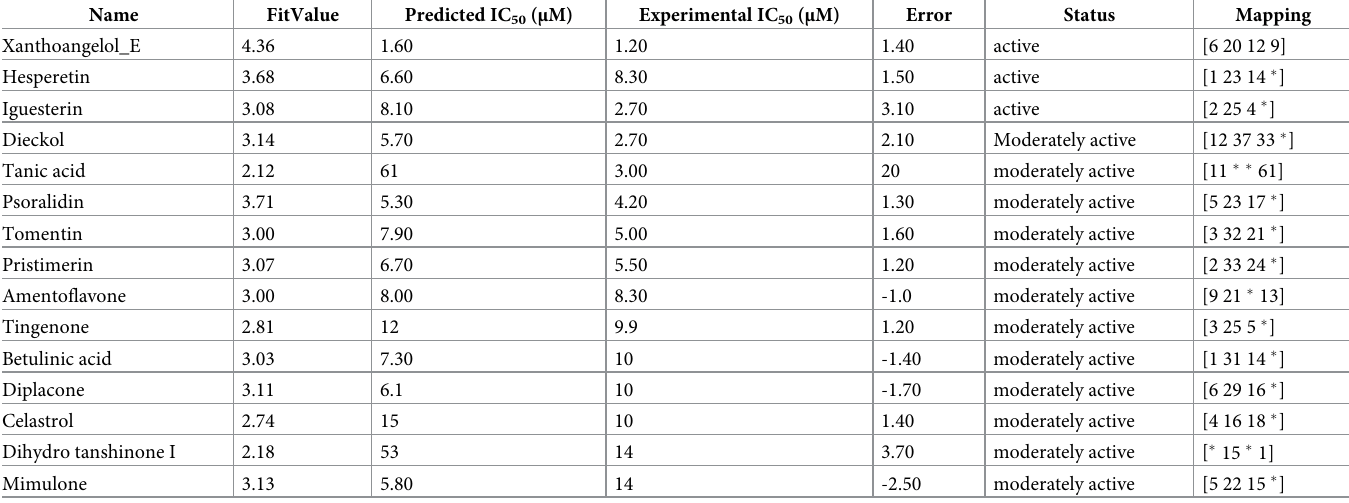
which is missing in the case of common feature pharmacophore.